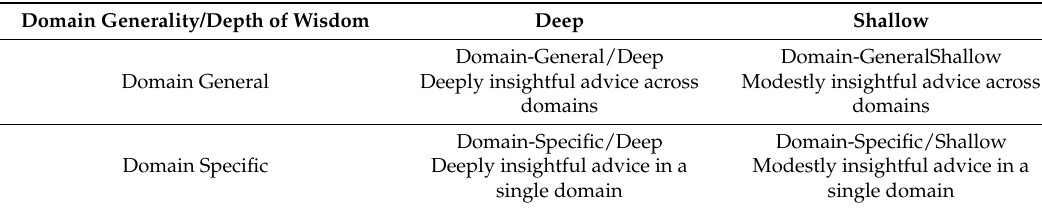
Table 1. Kinds of Wisdom.